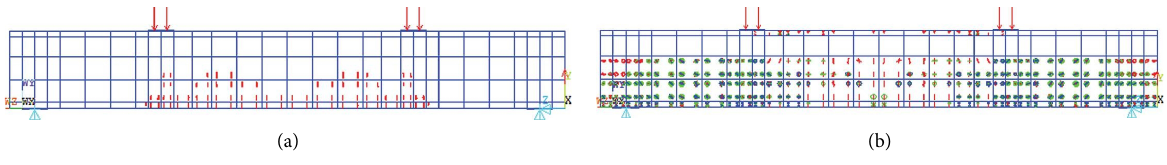
Figure 21: When the diameter of the compressed steel bars varied, cracking and damage began to appear in the beams: (a) cracks begin to appear in the beam ( P crack � 9kN), 2 ϕ 16; (b) damage to the beam begins to appear ( P max � 131kN), 2 ϕ 16.